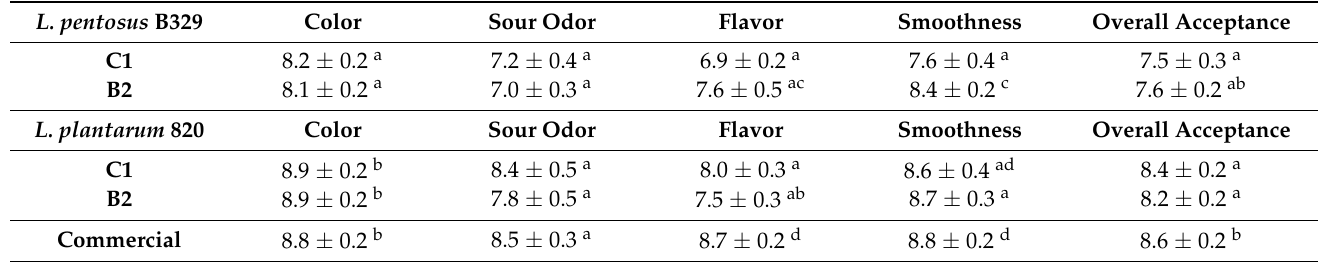
Table 3. Sensory evaluation of sour milk produced by LAB